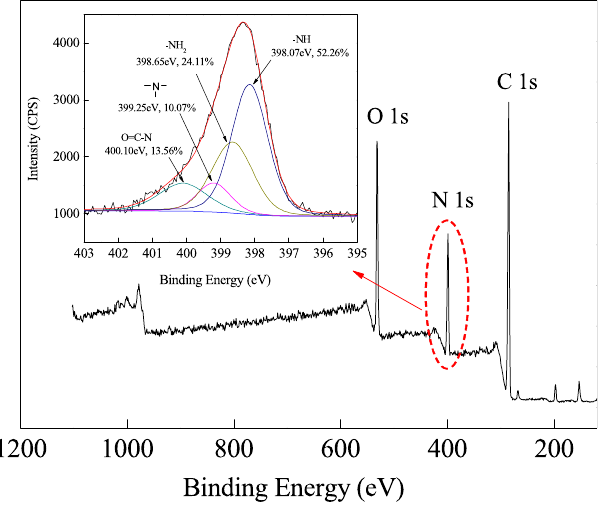
Figure 6. N1s peak processing of XPS of PP-AM-HBP-NH 2